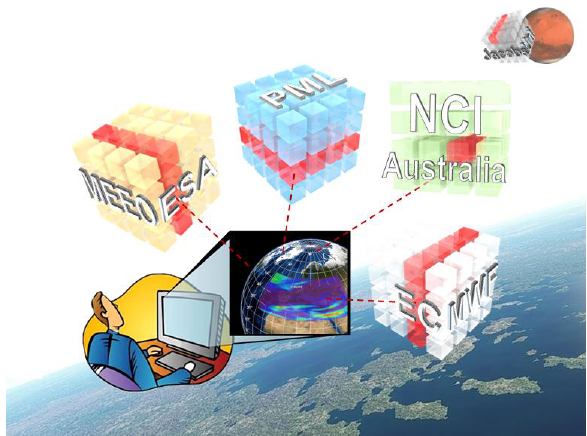
Figure 8. Intercontinental datacube mix and match